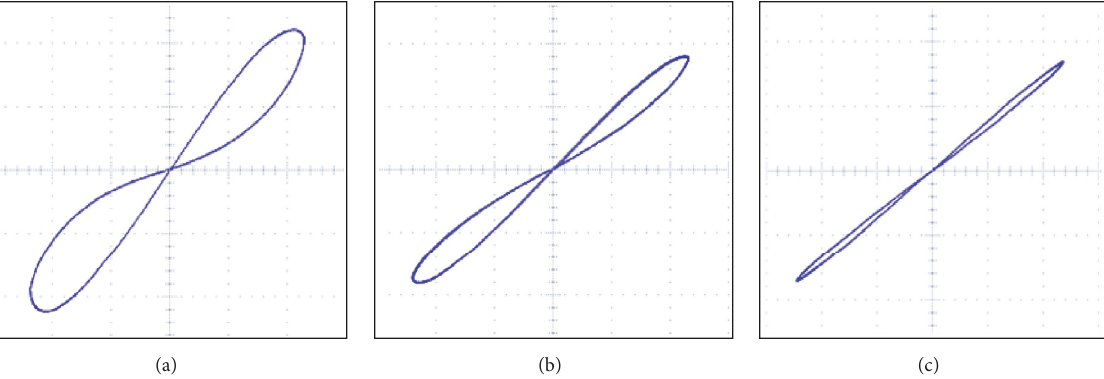
Figure 7: Experimental results of the incremental type emulator when 𝐶 1 = 𝐶 2 = 10 nF. (a), (b), and (c) represent hysteresis loops in V - 𝑖 plane operating at 100 Hz, 500 Hz, and 1kHz, respectively. The scales are 0.2 V/div for 𝑥 -axis and 0.2 V/div for 𝑦